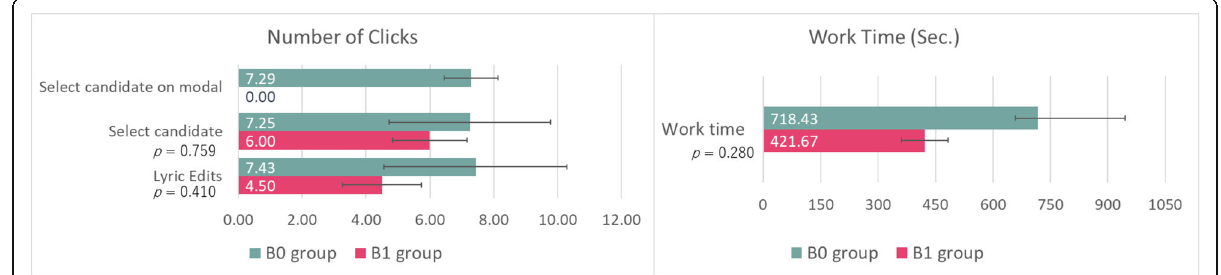
Fig. 9 Comparison of number of clicks and work time between B0 and B1